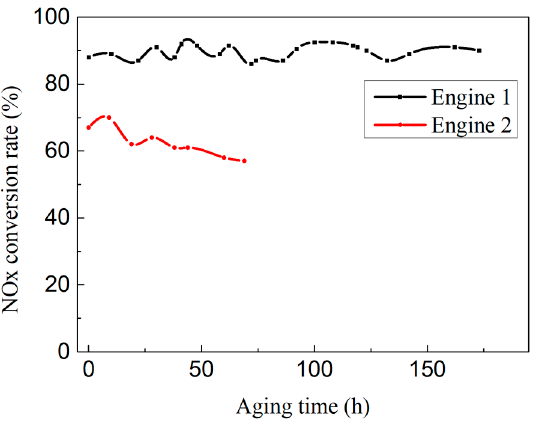
Figure 14. NOx conversion rate for engine 1 and 2 as a function of operating time.